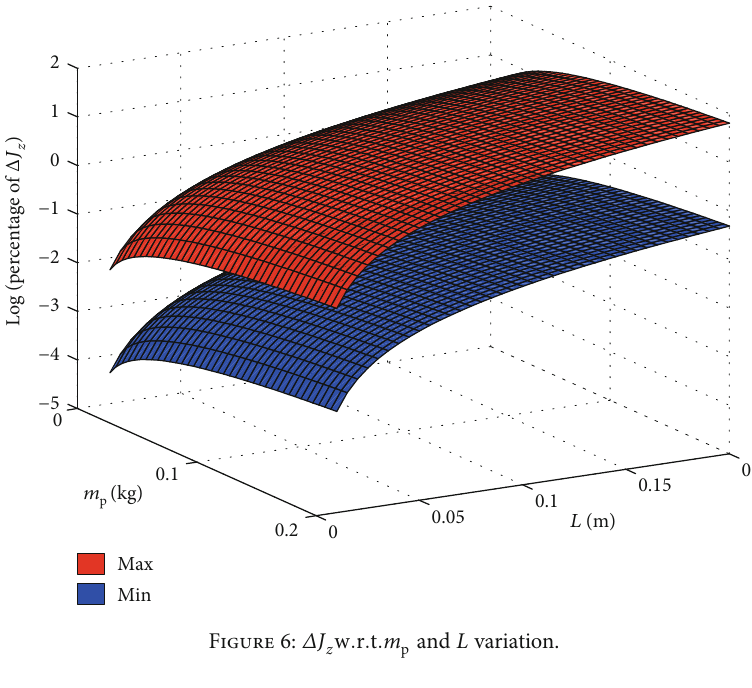
w : r : t : m and L variation. p z